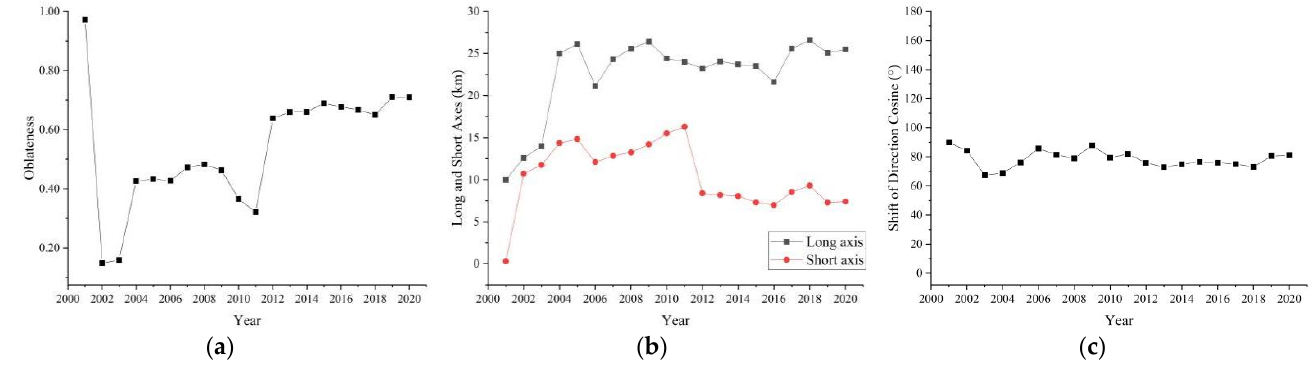
Figure 17. Zhengzhou data from 2001–2020 standard deviation ellipse parameters: ( a ) oblateness, ( b ) long and short axes, and ( c ) shift of cosine direction.